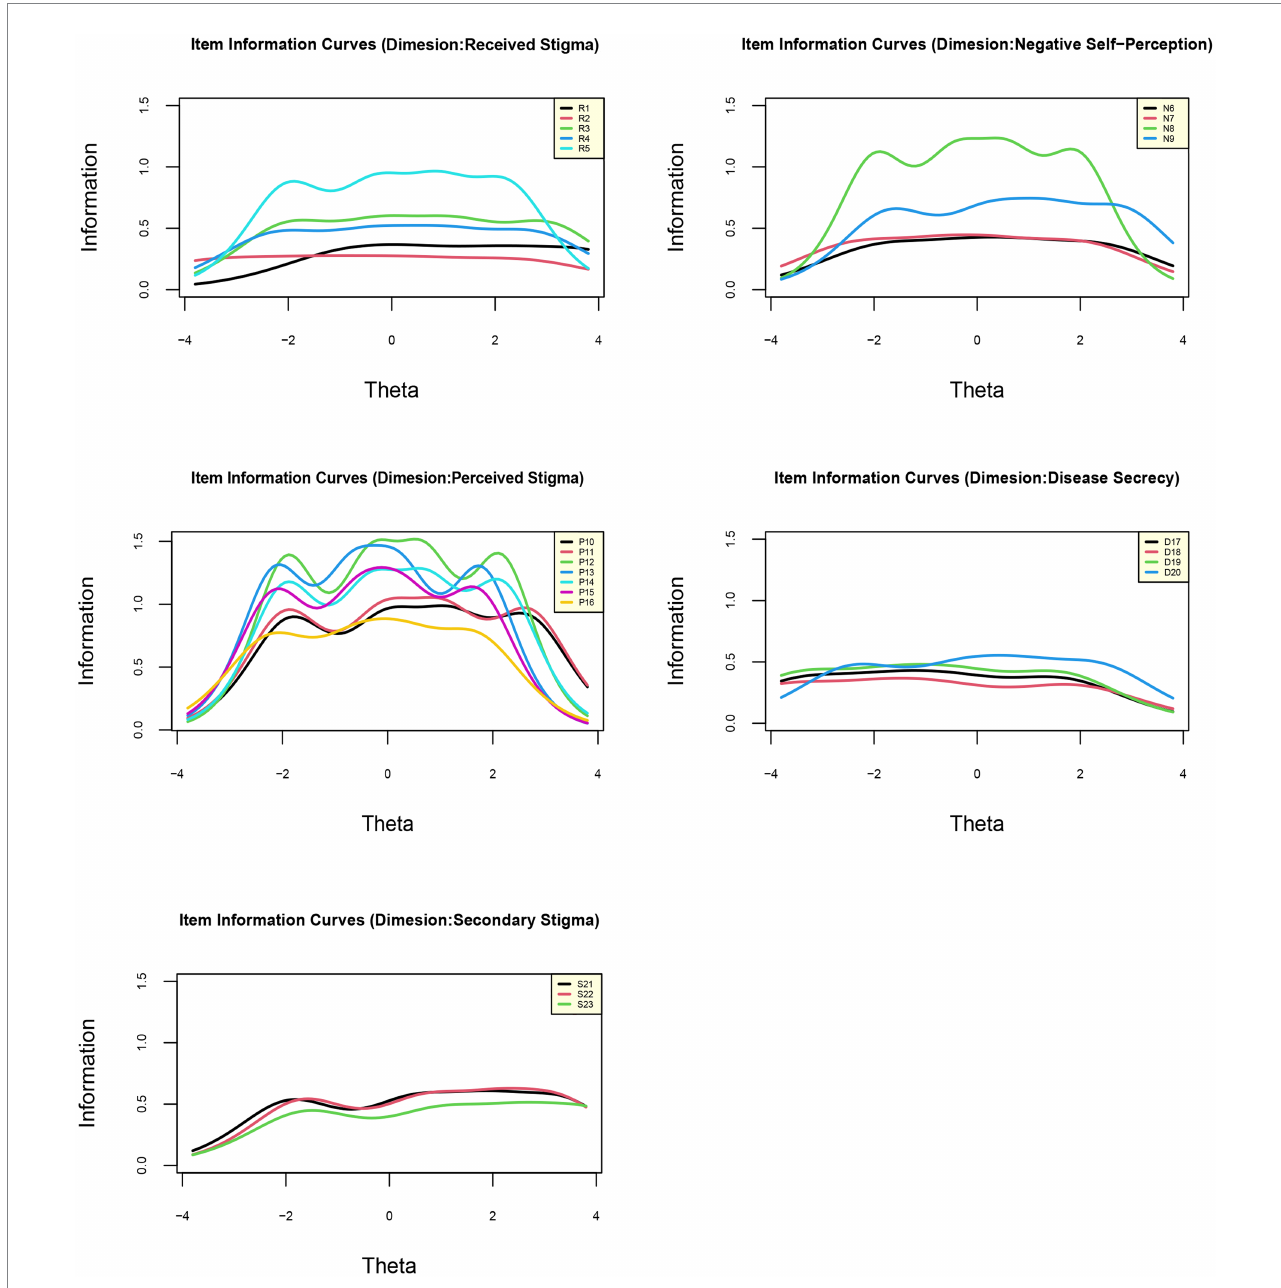
FIGURE 3 Item information curves of five dimensions of hepatitis B virus infection-related stigma scale